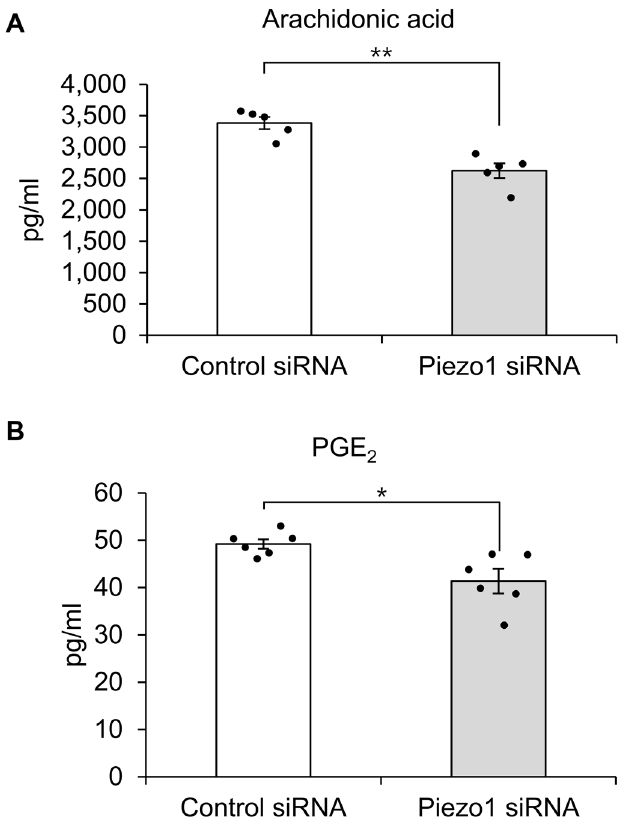
Figure 5. The impact of Piezo1 knockdown on the release of arachidonic acid and PGE 2 following mechanical stretch stimulation in human trabecular meshwork cells. In human trabecular meshwork cells transfected with control or Piezo1 siRNAs, Cell supernatants were collected 10, 30, and 60 min after stretch stimulation. The levels of arachidonic acid ( A ), PGE 2 ( B ) in the cell supernatant were measured. Piezo1 knockdown suppressed the release of arachidonic acid ( A ) and PGE 2 ( B ). Data are expressed as mean ± SE (n = 3 samples of lipid mediators extracted from cell supernatant in 3 chambers). * p < 0.05. ** p < 0.01, two-tailed Student’s t